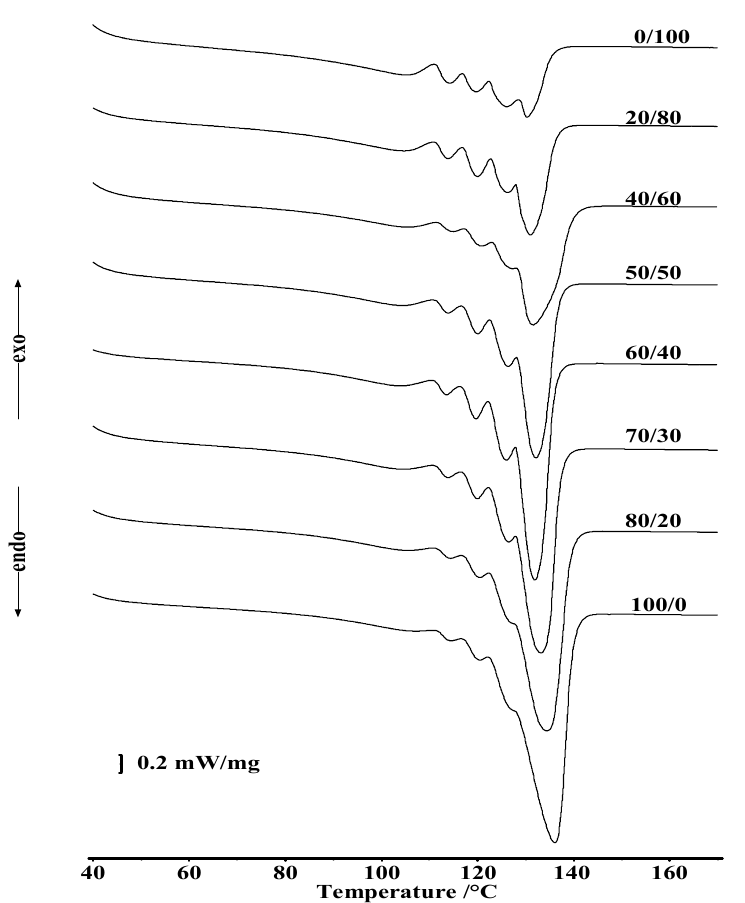
Figure 4. Effect of LLDPE on the self-nucleation and annealing (SSA) curves of HDPE-1/LLDPE composites.